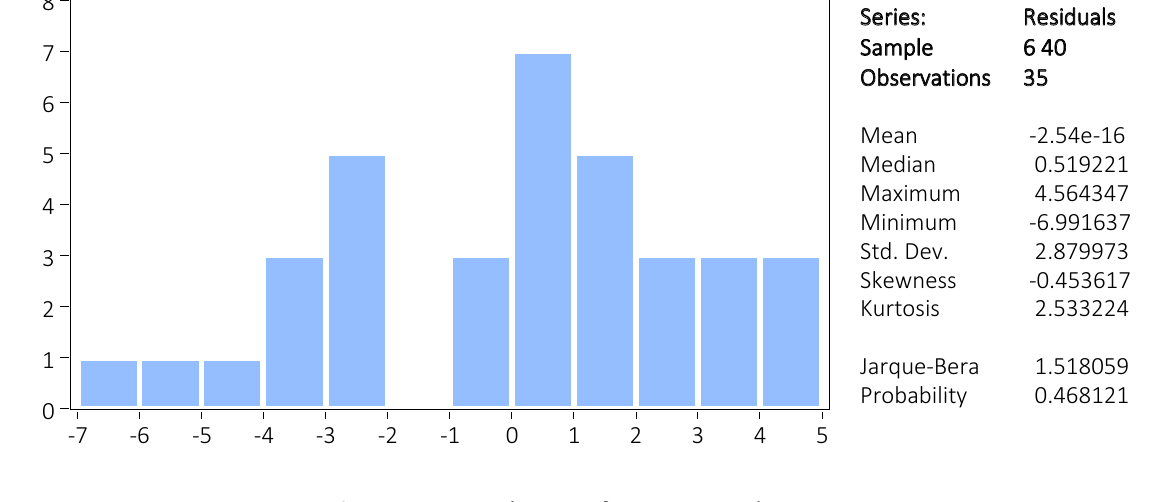
Figure 4. Normality test for MAMF and